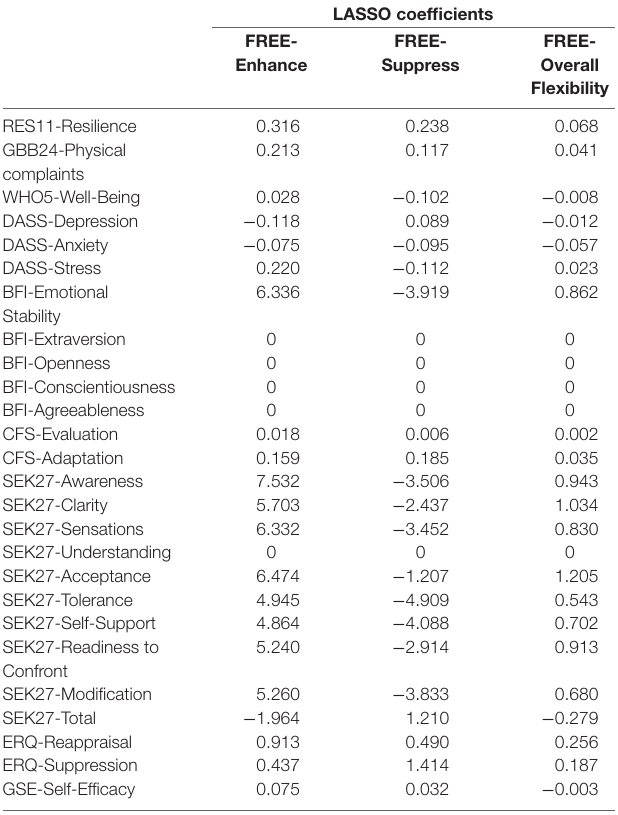
TABLE 3 | LASSO coefficients of each of the Second-Order Factors and Overall Expressive Flexibility (EF) of the FREE Scale. LASSO